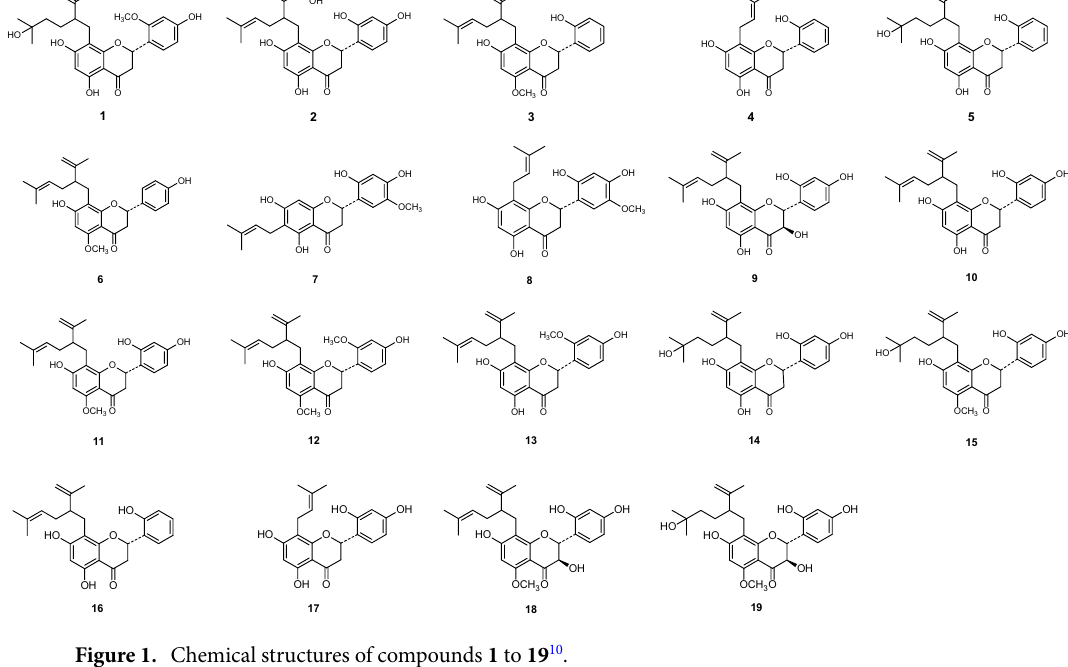
Figure 1. Chemical structures of compounds 1 to 19 10 .